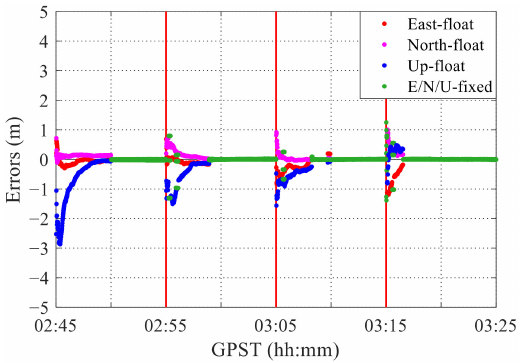
Figure 18. Results of RTK segmented positioning in choke-coil experiment. Table 10. Statistical results of RTK segmented positioning in choke-coil